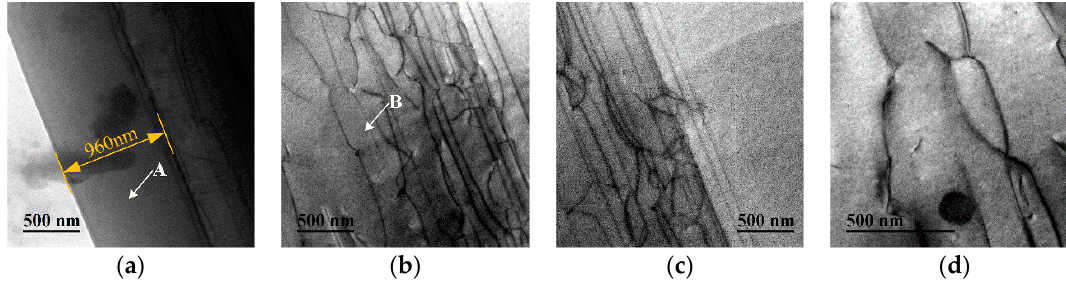
Figure 8. Low-resolution TEM images of sample cross-section ( a ) around Ge 0.2 Si 0.8 layer, ( b , c ) at Ge x Si 1 − x /C-Si interface and ( d ) inside Ge x Si 1 − x layer with a dislocation loop.